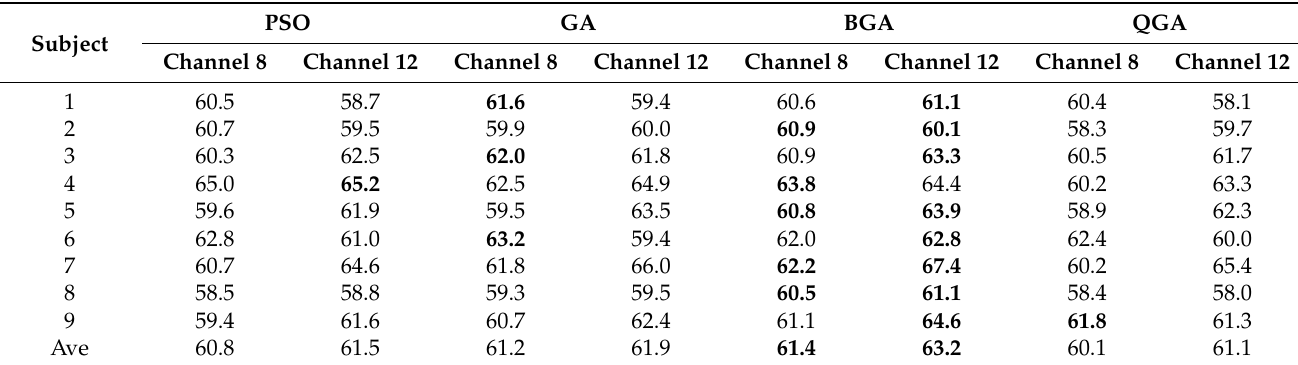
Table 8. Feature selection accuracy of PSO, GA, and BGA with 100 features, FB5, and ELM for 100